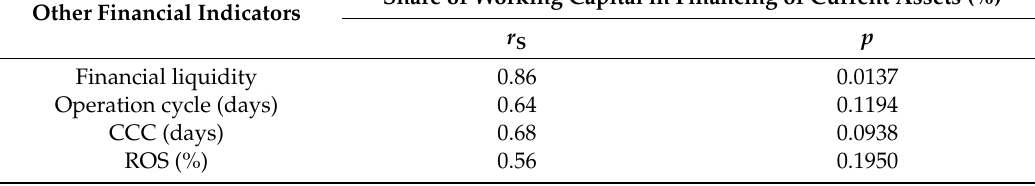
Table 9. Correlation analysis of the share of working capital in financing of current assets ratio with other selected financial indicators.